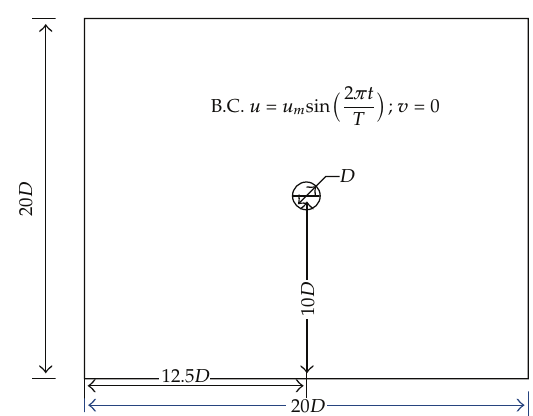
Figure 1: Schematic of interaction of an oscillatory flow with a single circular